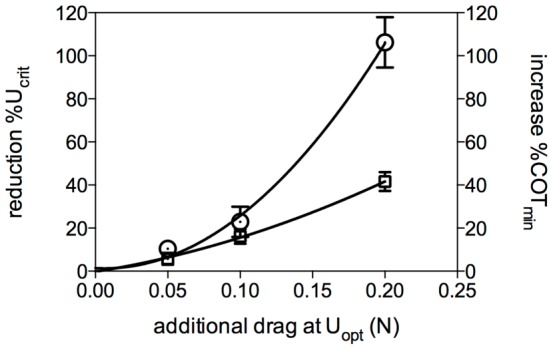
Relation of critical swimming speed (Ucrit) and minimum Cost Of Transport (COTmin) with added drag.Percentual decrease of Ucrit (reduction %Ucrit; □) and percentual increase of COTmin (increase %COTmin; ○) per individual, plotted against additional drag force (FD, N, measured at Uopt, 0.68 m s−1) of small (FD = 0.05 N), intermediate (FD = 0.10 N) and large dummies (FD = 0.20 N) at site A. The resulting polynomial graph with best fit (r2>0.99) followed the formula red%Ucrit = 102.8±49.35FD
2+527.7±273.8 FD and inc%COTmin = −8.9±113.0FD
2+2687±636.7FD, respectively.